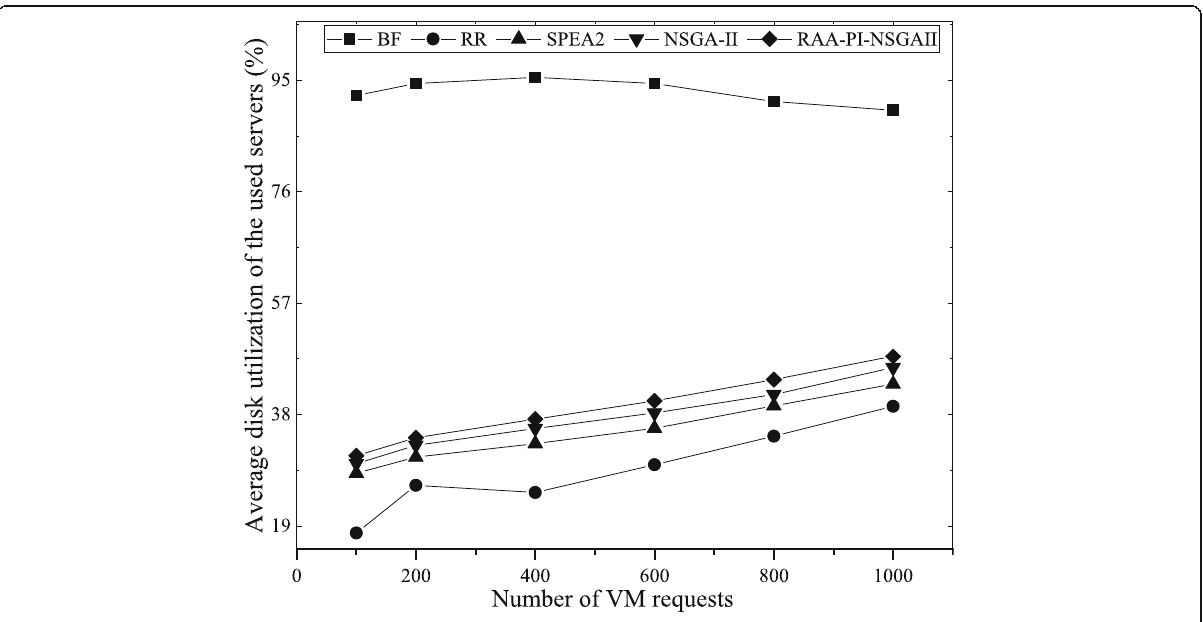
Fig. 9 Average disk utilization of the used physical servers